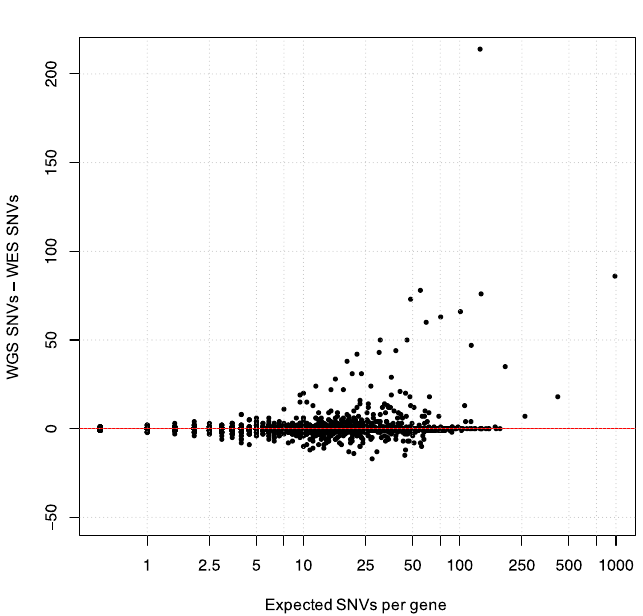
Figure 3. Gene-wise platform bias. Each individual point on the scatterplot is a gene with the y axis displaying differences in SNP counts per gene. Genes with more WGS SNPs than WES SNPs have positive values, where genes have negative values when there is more WES SNPs instead. Expected SNP number is calculated as the mean number of SNPs per gene across both platforms and is plotted on a log